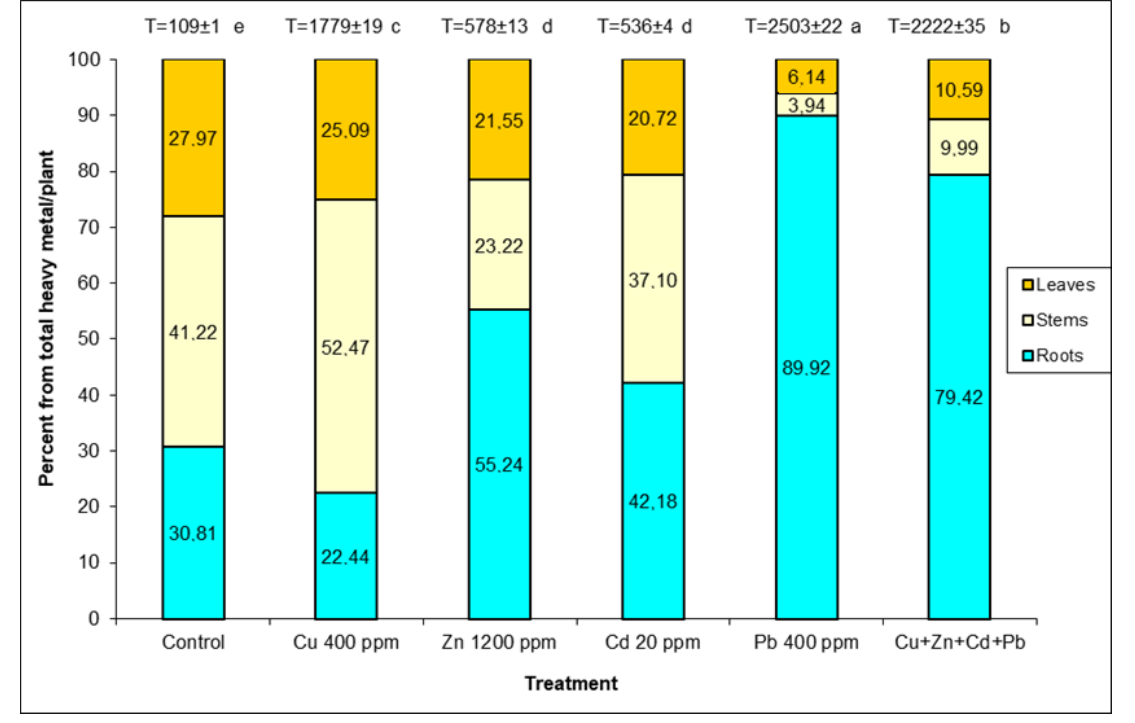
Figure 1. Percentage distribution of accumulated heavy metals in organs of S. perfoliatum plants grown under different treatments. T-total accumulated heavy metals ( µ g g − 1 DW) in plant. Means ( ± SE) with different letters are significant at p < 0.05 according to Tukey test.